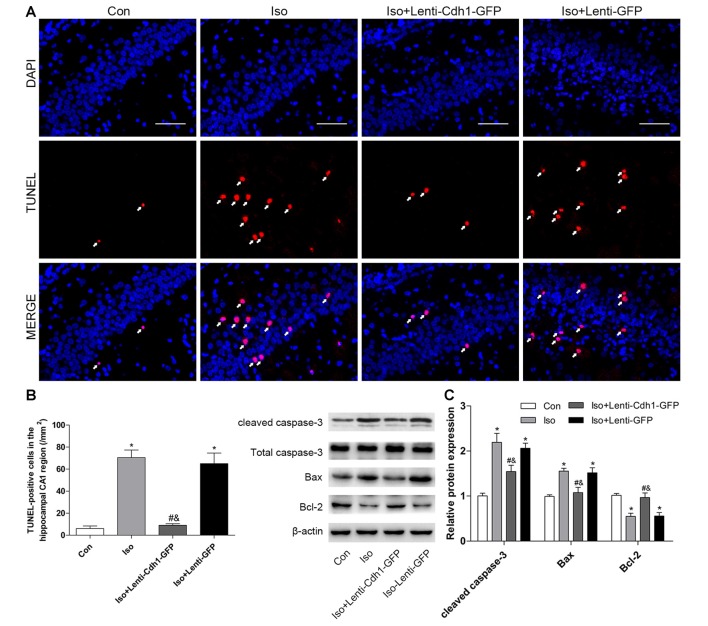
Bilateral intra-hippocampal injection with Cdh1-encoding lentivirus decreases isoflurane-induced neuronal apoptosis in the developing hippocampus. (A) Representative images of TUNEL-assay in the hippocampal CA1 region are shown. Red color indicates TUNEL-positive cells; blue indicates the nucleus. Scale bar = 50 μm. (B) The lower histogram shows the number of TUNEL-positive cells in the hippocampal CA1 region (n = 6 in each group). (C) The western blot bands (left) and quantitative data (right) show the effect of the lentivirus and isoflurane-treatment on the expression of cleaved caspase-3, Bax and Bcl-2 in the developing brain in different groups (n = 3 in each group). *P < 0.05 vs. control group, #P < 0.05 vs. Iso group, &P < 0.05 vs. Iso + Lenti-GFP group.